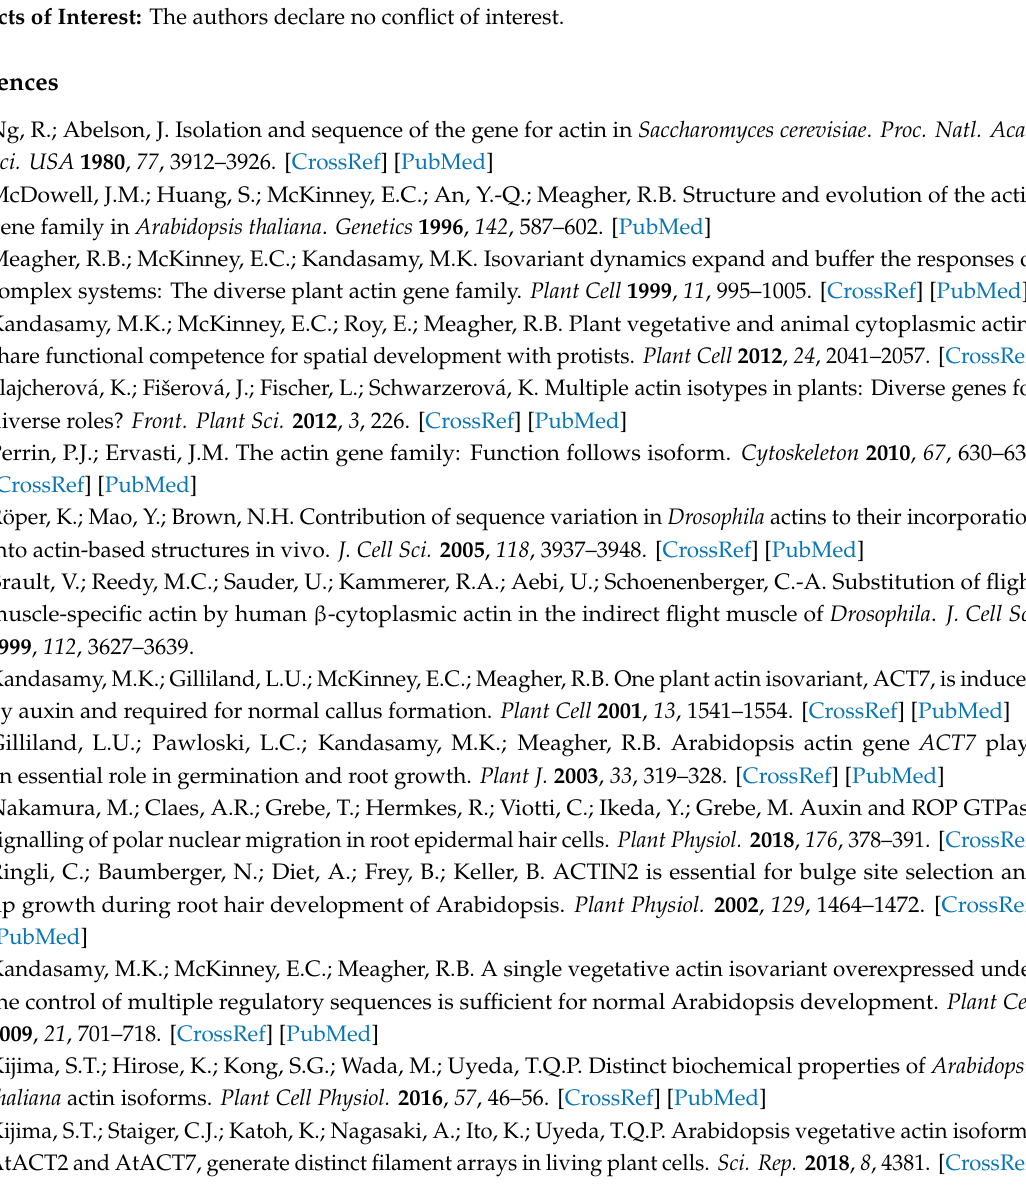
Table S1: List of primers used in this study. Table S2: Expression of UBC21 in isolated protoplasts cultured for 0, 48 and 96